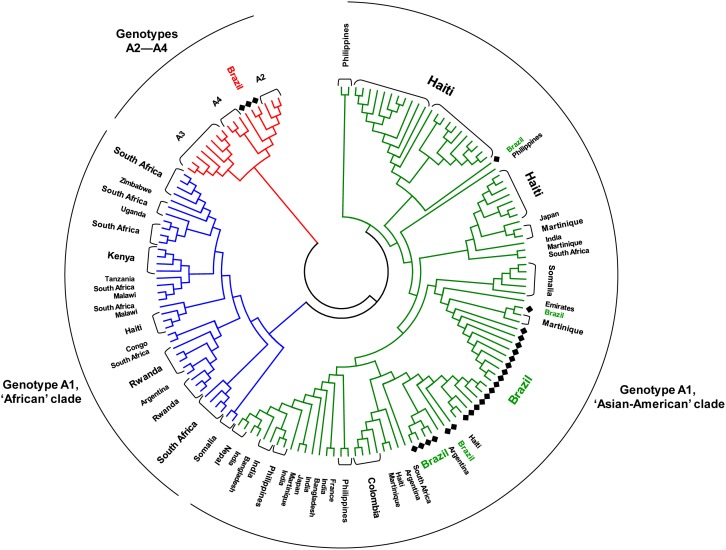
Phylogenetic analysis based on HBV complete nucleotide sequences.The phylogenetic tree, performed by using the maximum likelihood method, incorporates 134 HBV/A1 isolates, including the 23 Brazilian isolates sequenced in this study. Subgenotype A1 strains separated into two clades, ‘African’ (blue) and ‘Asian-American’ (green). In addition, sequences of A2, quasi-subgenotype A3 and A4 samples were included as an outgroup (red), which allowed three Brazilian samples to be classified as subgenotype A2. The list of the GenBank accession numbers of the isolates with their subgenotypes and countries of origin is shown in Table S1.